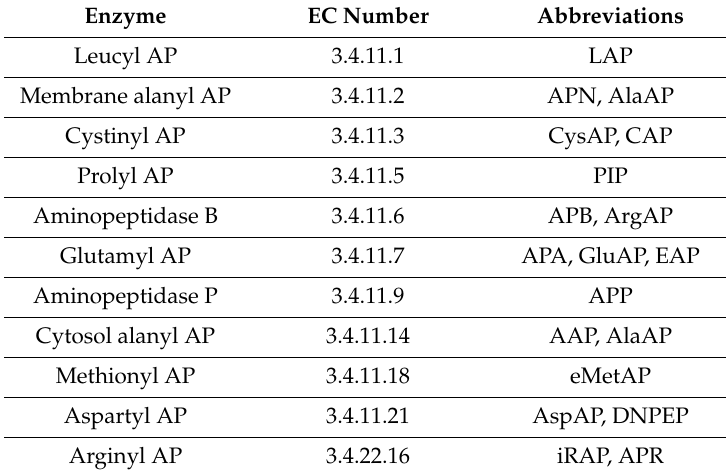
Table 1. Types of aminopeptidases showing their most common abbreviations. Enzyme EC Number Abbreviations Leucyl AP 3.4.11.1 LAP Membrane alanyl AP